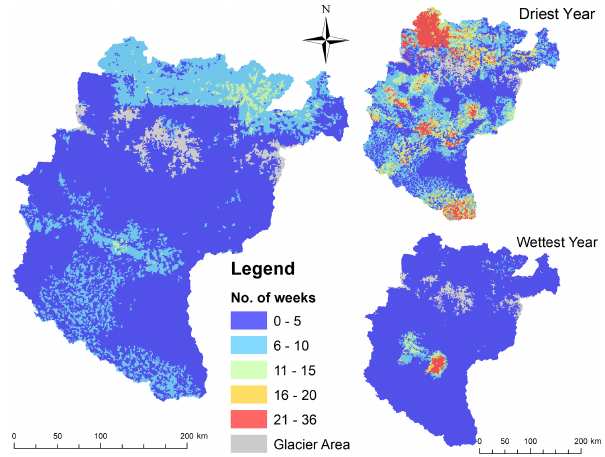
Figure 11. Spatial maps of average duration of drought, i.e. SMDI < − 3 . 0, driest year (1992), and wettest year